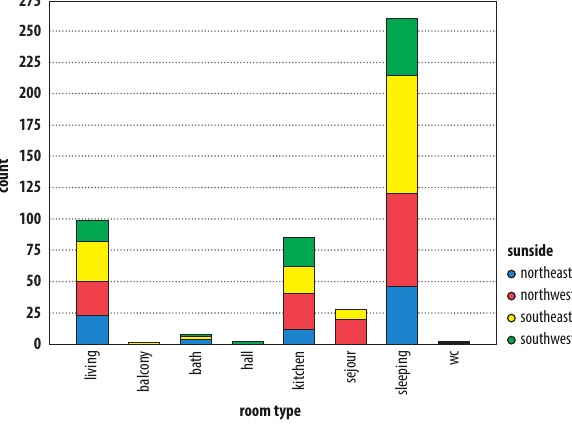
Figure 6. The distribution of functional uses with regard to sun side in